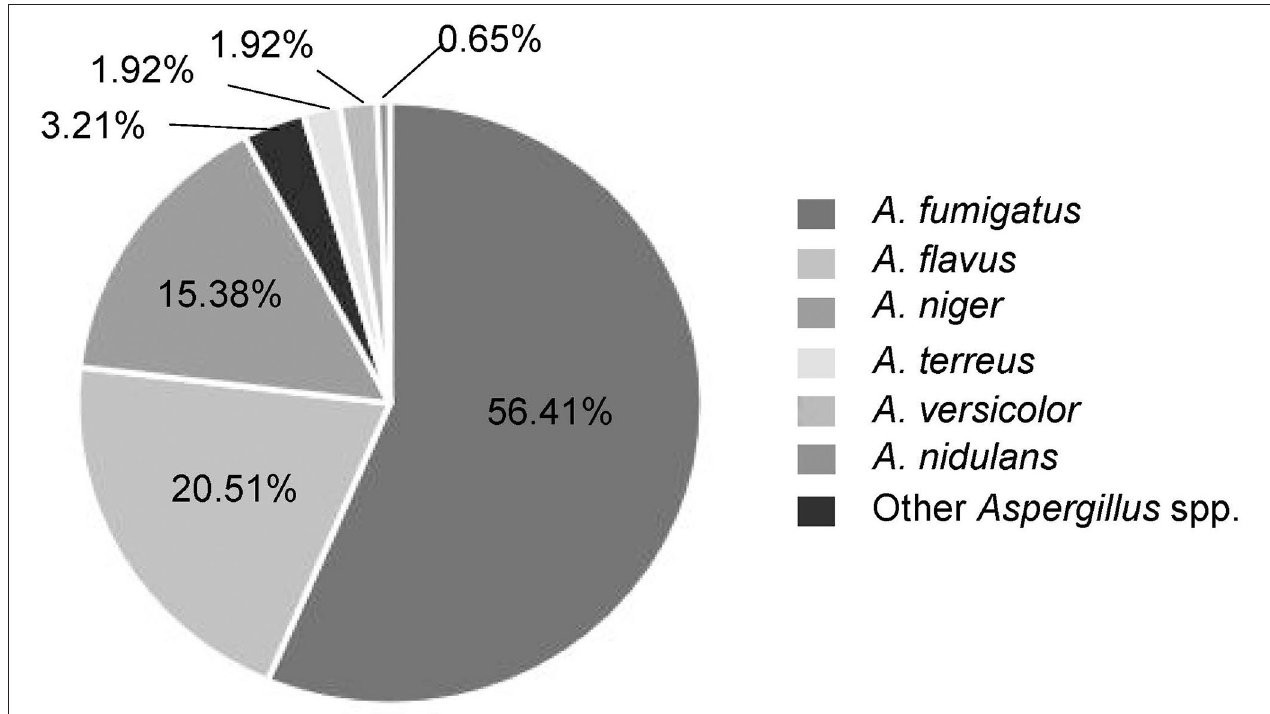
FIGURE 2 | The species distribution of 156 Aspergillus isolates in the present study.